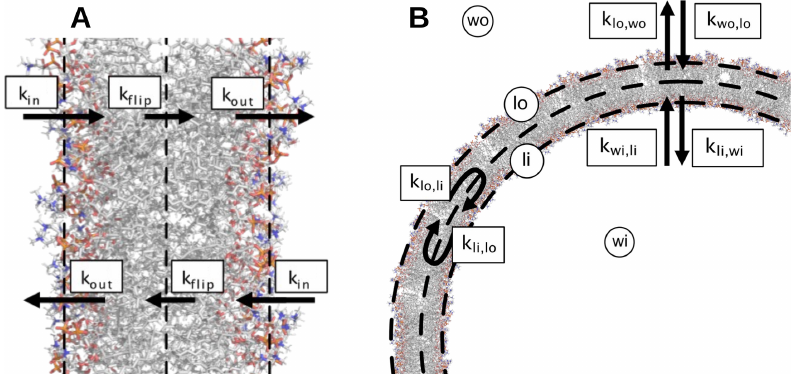
Figure 6. Designation of the kinetic rate constants in membrane planar ( A ) and spherical ( B ) geometry. In the liposome model, wo and lo stands for the outer water and lipid compartment, respectively, and similarly for the two inner compartments wi and li